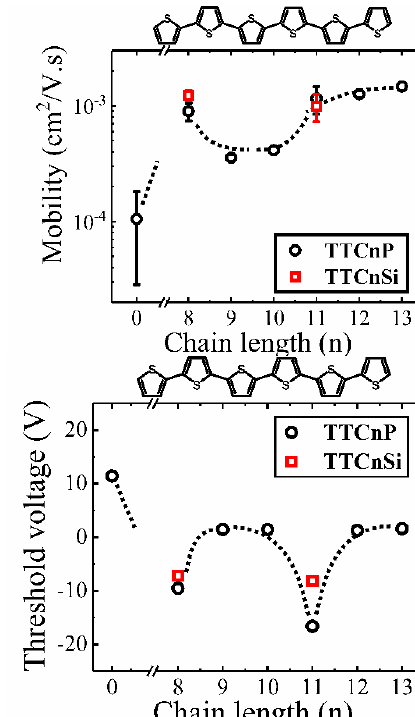
Figure 4. Output characteristics of pentacene OFET devices (channel length L of 50 μm) with ( a – c ) pentacene or ( d – f ) α -sexithiophene layer deposited on ( a , d ) bare SiO 2 surface or SAM-modified surface with ( b , e ) TTC11Si and ( c , f ) TTC11P .